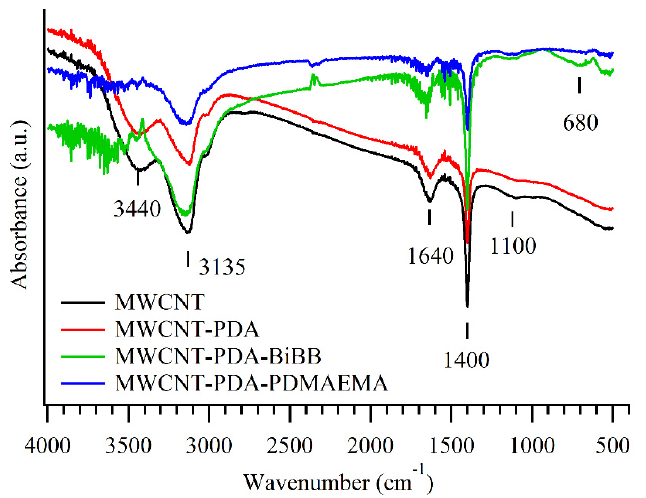
Figure 1. FTIR of MWCNTs, MWCNTs-PDA, MWCNTs-PDA-BiBB, and MWCNTs-PDA-PDMAEMA.